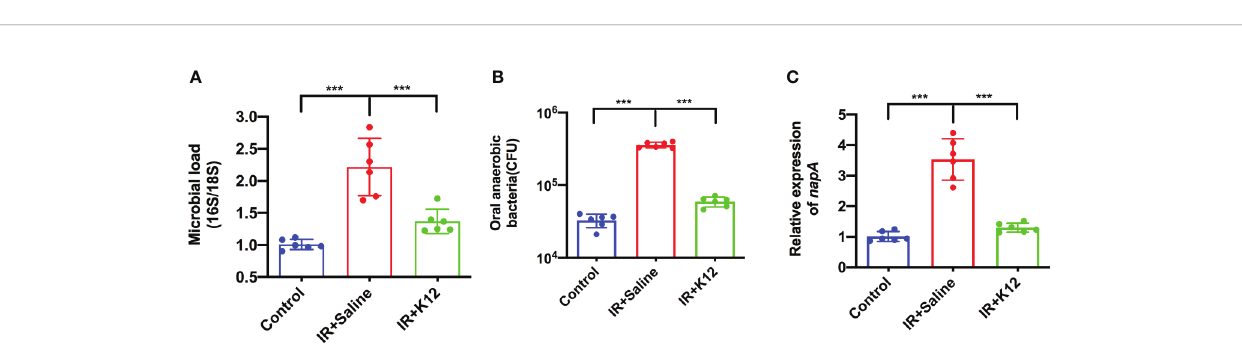
FIGURE 5 | Streptococcus salivarius K12 suppresses the overgrowth of oral anaerobes in RIOM mice. (A) Total bacteria in oral swabs were quanti fi ed by qPCR normalized as 16S/18S rRNA. (B) Total cultivable oral anaerobes in oral swabs. (C) Relative expression levels of nitrate reductase napA gene of oral microbiota. Data are presented as mean ± SD. N=6 per group. One-way ANOVA test followed by Tukey ’ s test. *** P <